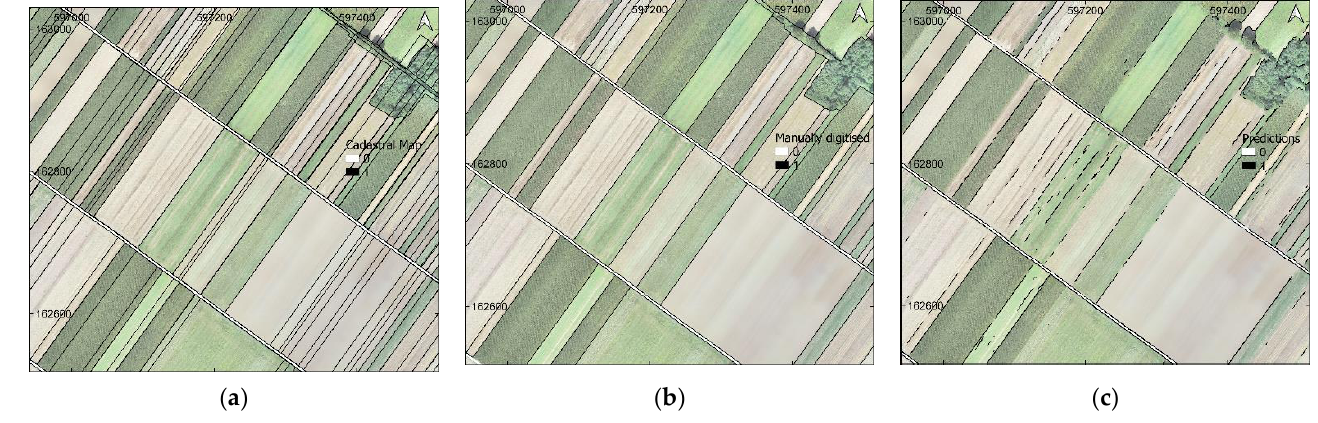
Figure 10. Revision of cadastral map in Odranci: ( a ) Cadastral boundaries; ( b ) manually vectorised visible boundaries; and ( c ) predicted visible boundaries with customised CNN; ( a – c ) overlaid on UAV imagery. Table 6. Assessment of the overlap between cadastral boundaries and land visible boundaries— Odranci. Ponova vas.